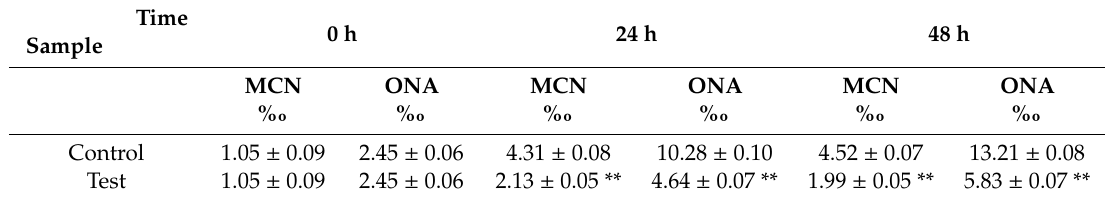
Figure 6. Micronuclei in blood cells of F. multistriata tadpoles treated with M. aeruginosa : M. aeruginosa ( a ) treated by P. chrysosporium ( b ).